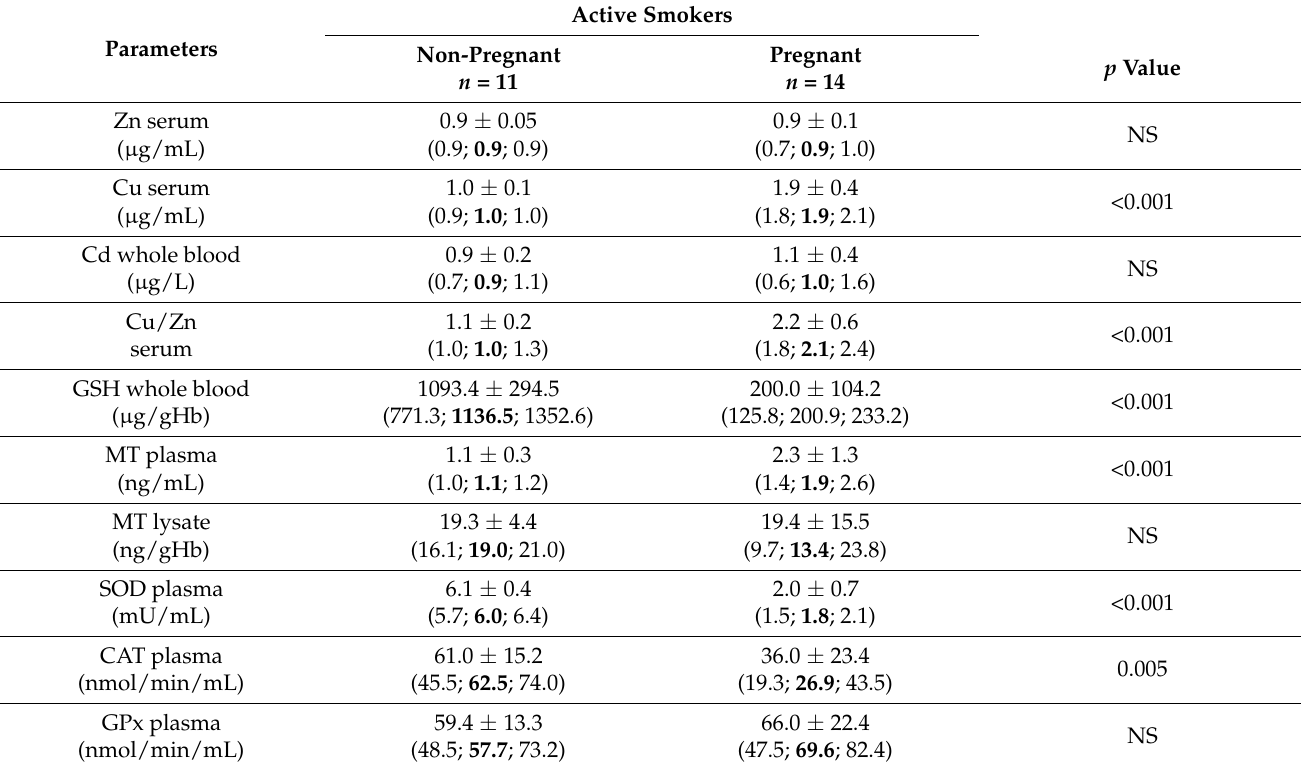
Table 3. Values of selected antioxidative parameters, and metals in